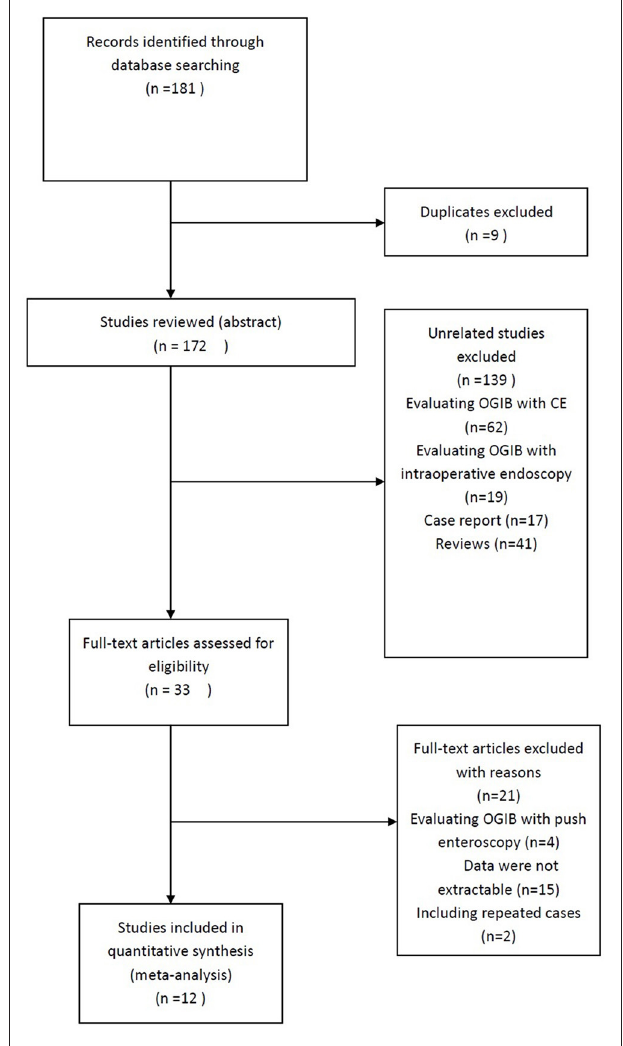
FIGURE 1 | Study selection flow chart. Of a total of 181 studies, only 12 studies met selection